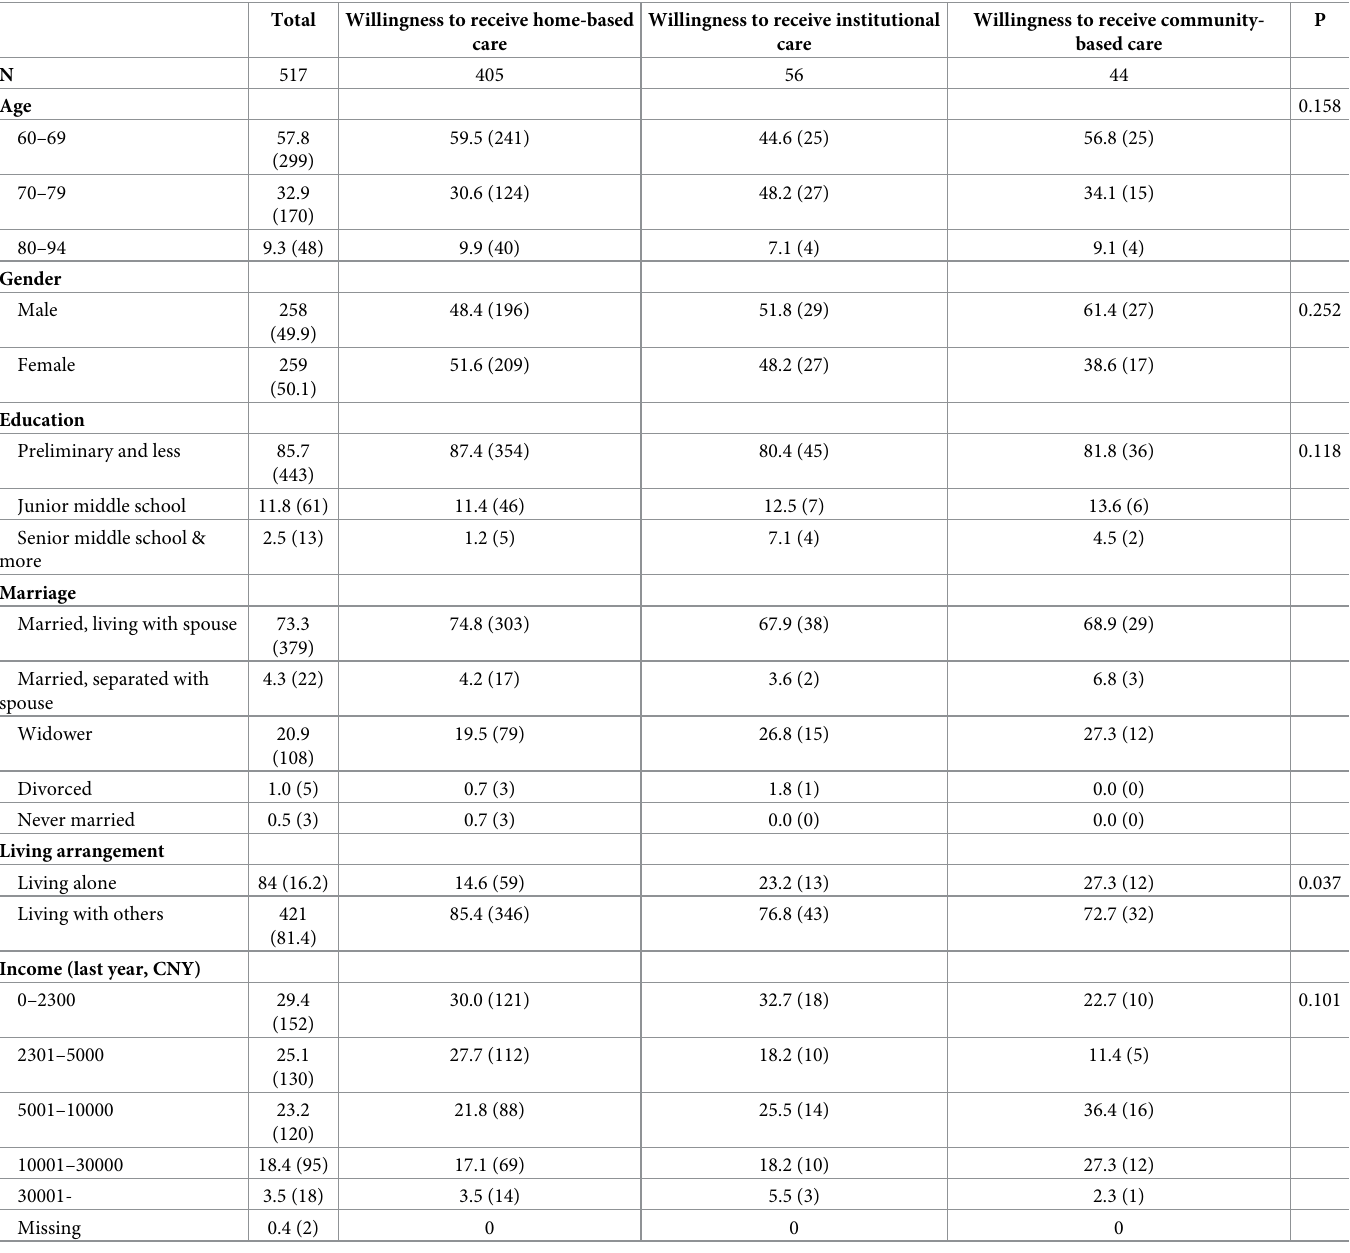
Table 1. Demographic characteristic of